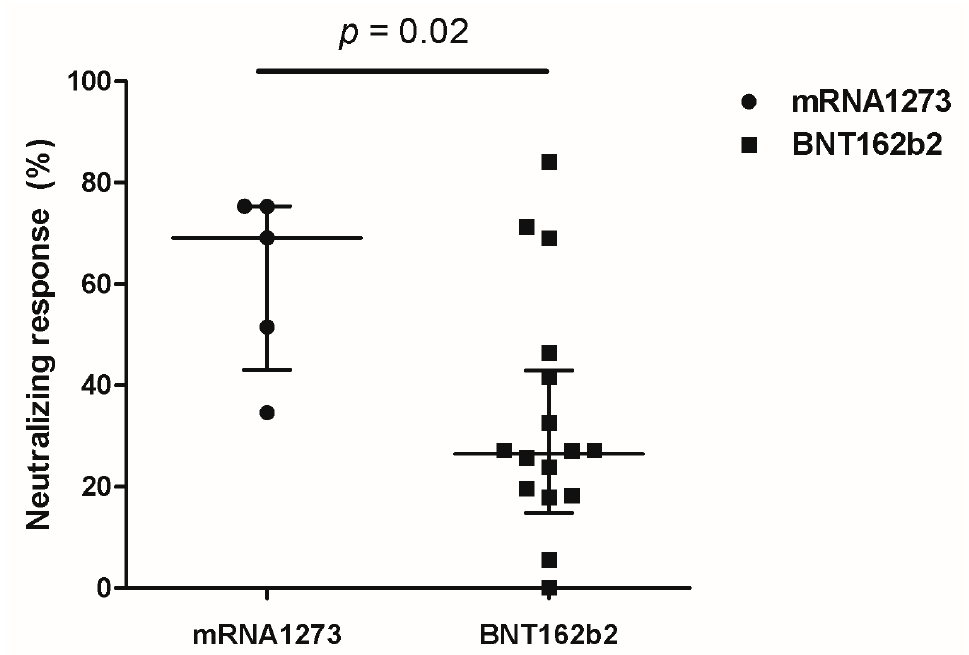
Figure 4. Neutralizing response against the Omicron variant in COVID-19-infection-naive students according to the type of booster vaccine.